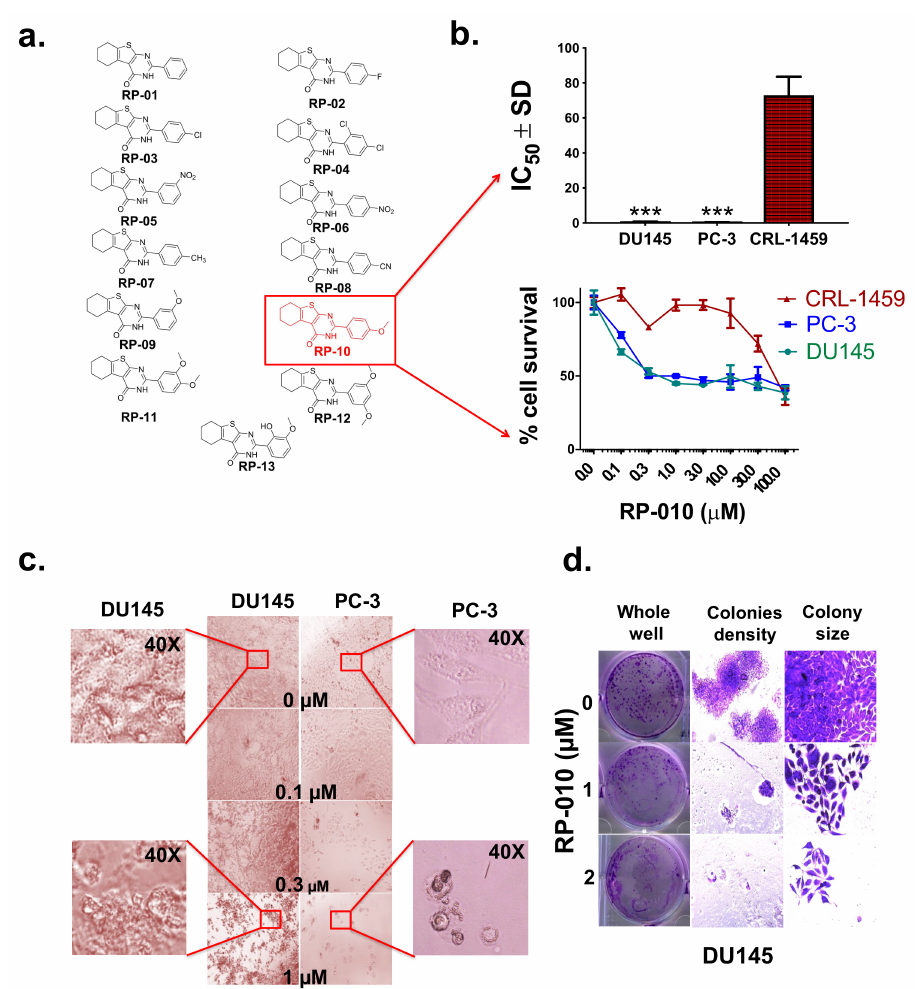
Figure 1. RP-010 cytotoxicity to prostate cancer cells. ( a ) An illustration of the chemical structures of the thirteen RP compounds. ( b ) RP-010 cytotoxicity to prostate cancer cells (DU145 and PC-3), as represented by survival curves (lower panel), and IC 50 values, compared to non-malignant CRL-1459 cells (upper panel). ( c ) Representative pictures of the morphological changes in cells incubated with RP-010 (0.1, 0.3, or 1 µ M), or vehicle, for 72 h. ( d ) Colony formation assay showing the e ff ect of RP-010 or vehicle (1 or 2 µ M) on the colony density (10 × ) and size (20 × ) of DU145 cells. All results are presented as the means ± SDs of three independent experiments. *** p <